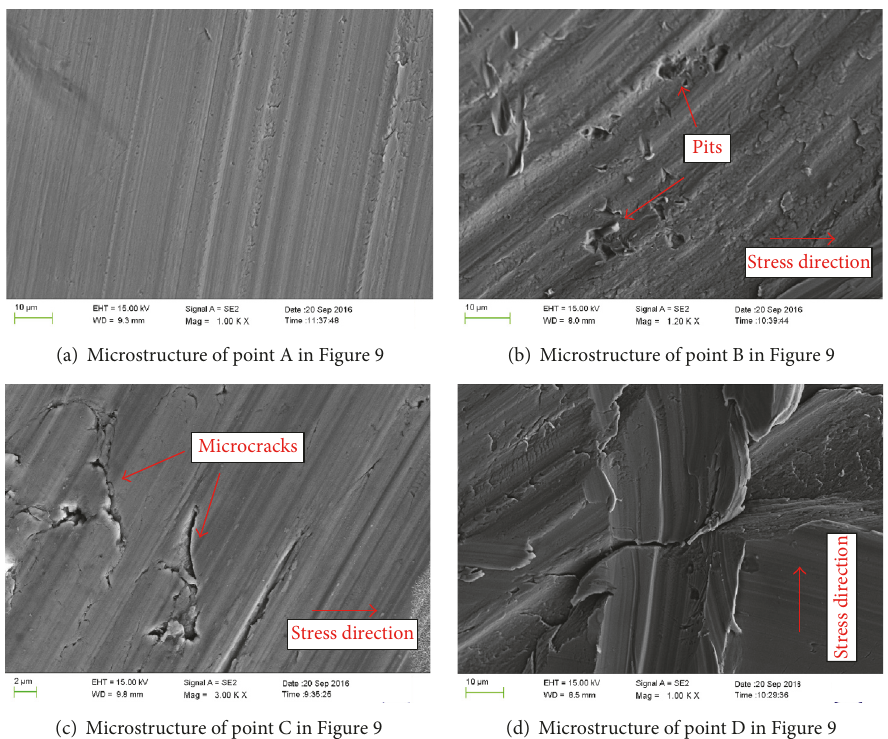
Figure 10: Microstructure of KMN-I bending fatigue